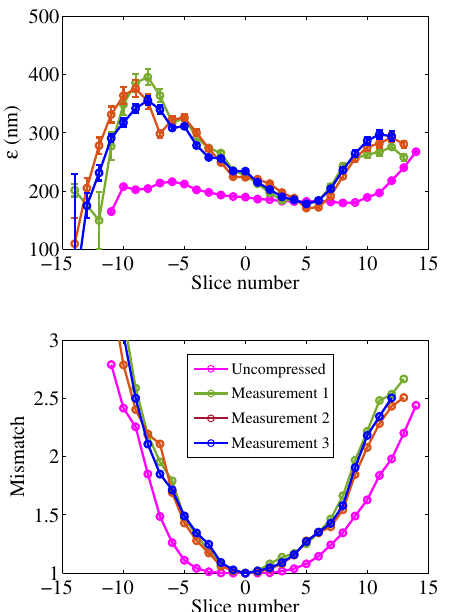
FIG. 18. Simulated horizontal slice emittance along the bunch for a compression factor of 15 after matching the bunch with low and high k -values in the matching quadrupoles. The vertical slice emittance of the compressed beam is shown for